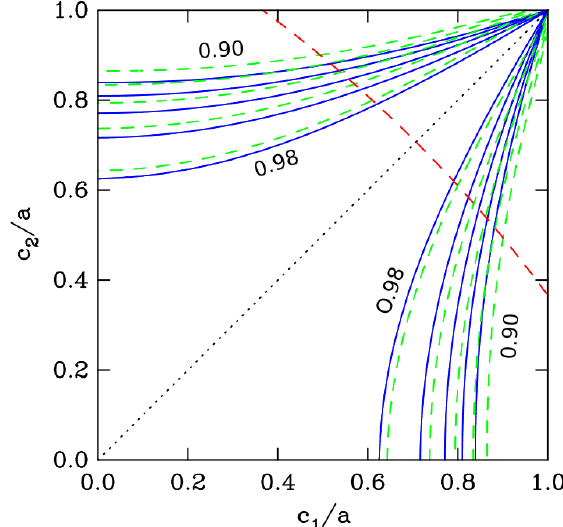
Figure 8. Contour plot of the thermal conductivity efficiency χ of the structure shown in Figure 7 versus the geometrical parameters c 1 / a and c 2 / a . The solid-line blue curves correspond to κ f = 0, the dashed-line green curves correspond to κ f = κ m /10. The dashed-line red curve is the range of parameters for which the volume-filling fraction f v is 0.5. From this curve up to the upper right corner of the figure, f v > 0.5.